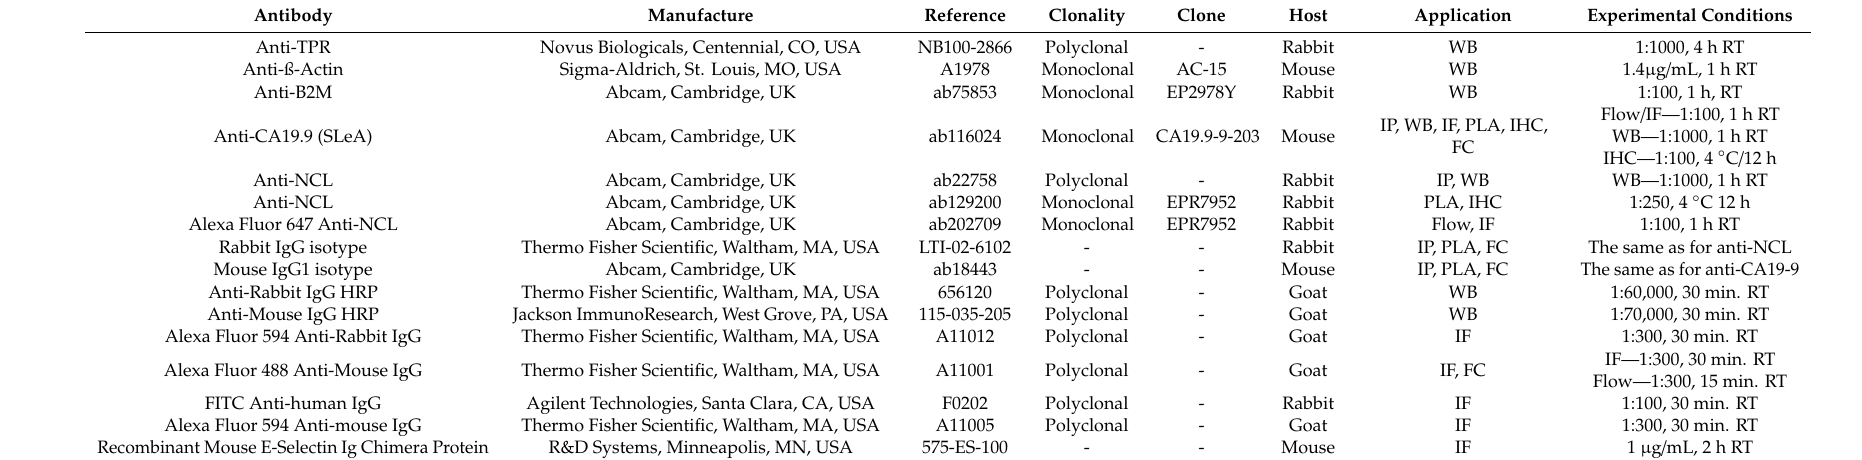
Table 1. Antibodies used in this study and corresponding experimental